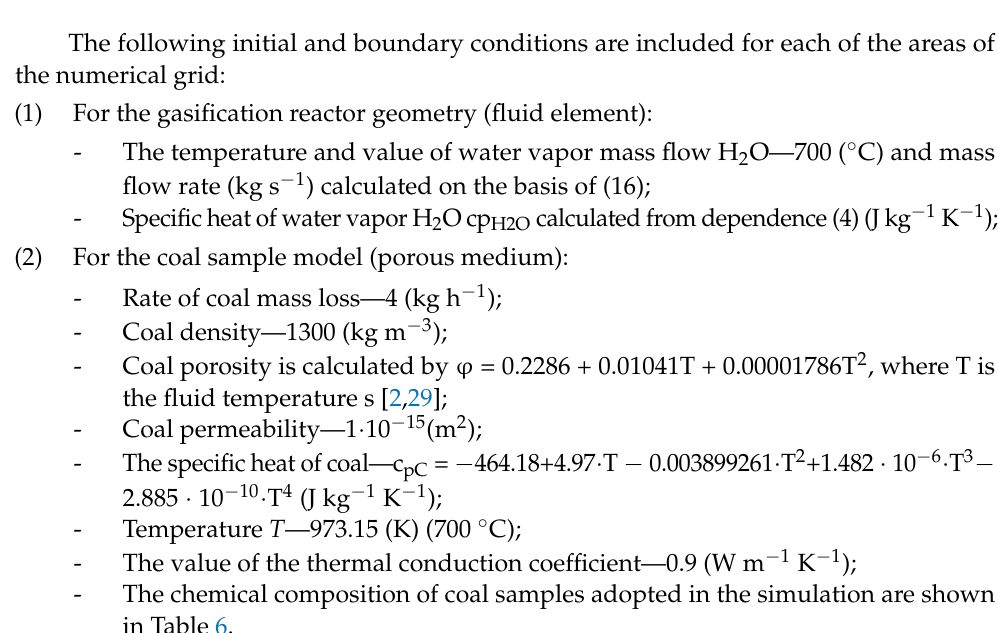
Figure 22. The measuring of syngas parameters at the outlet of the gasification reactor during numerical calculations.